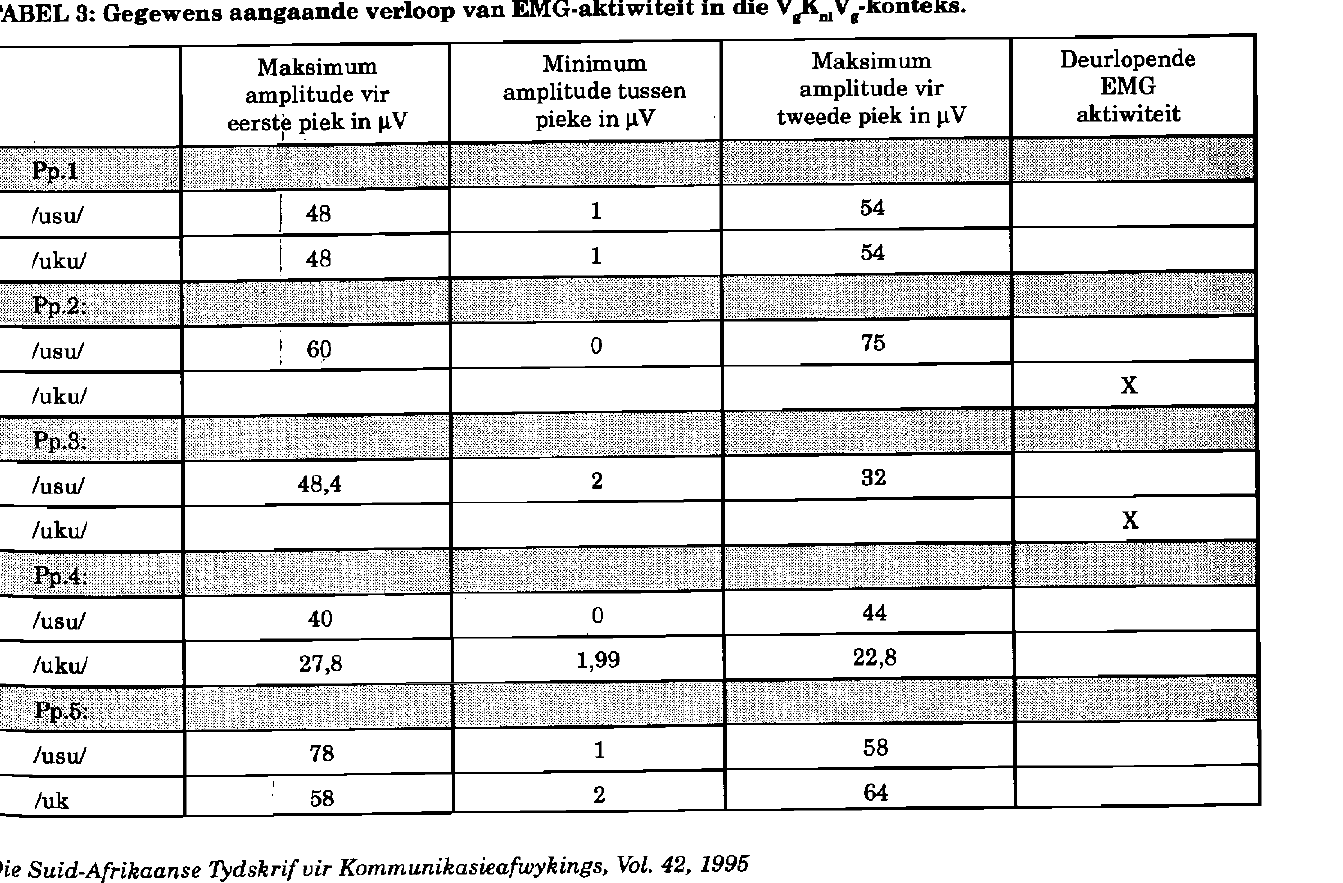
FIGUUR 4: Puntediagram van konsonantstring teenoor antisiperingstyd van eksperimentele materiaalgroep 1 vir proefpersoon 1.